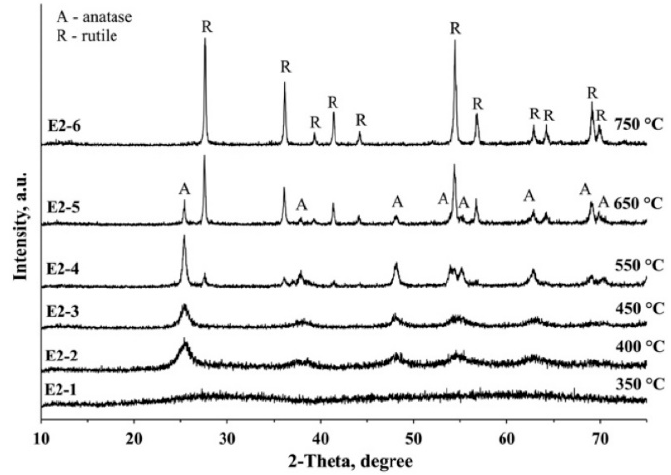
Figure 4. X ‐ ray diffraction patterns of nanocrystalline TiO 2 powders produced from the precursor E2 at different pyrolysis temperatures.